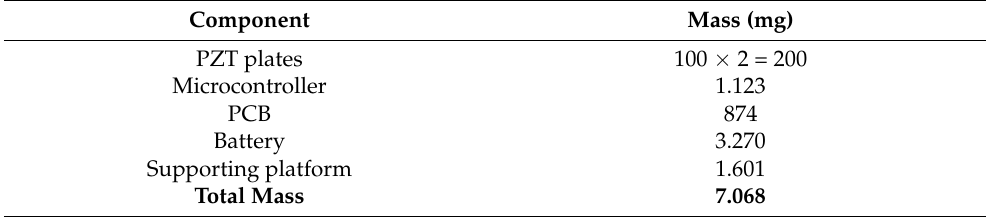
Table 1. Mass distribution of the robot.